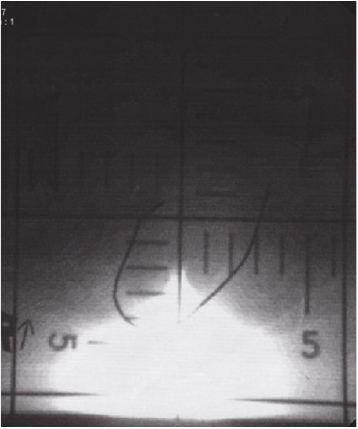
Figure 2: Localized small pelvic radiotherapy for endometrial cancer with prolapsed